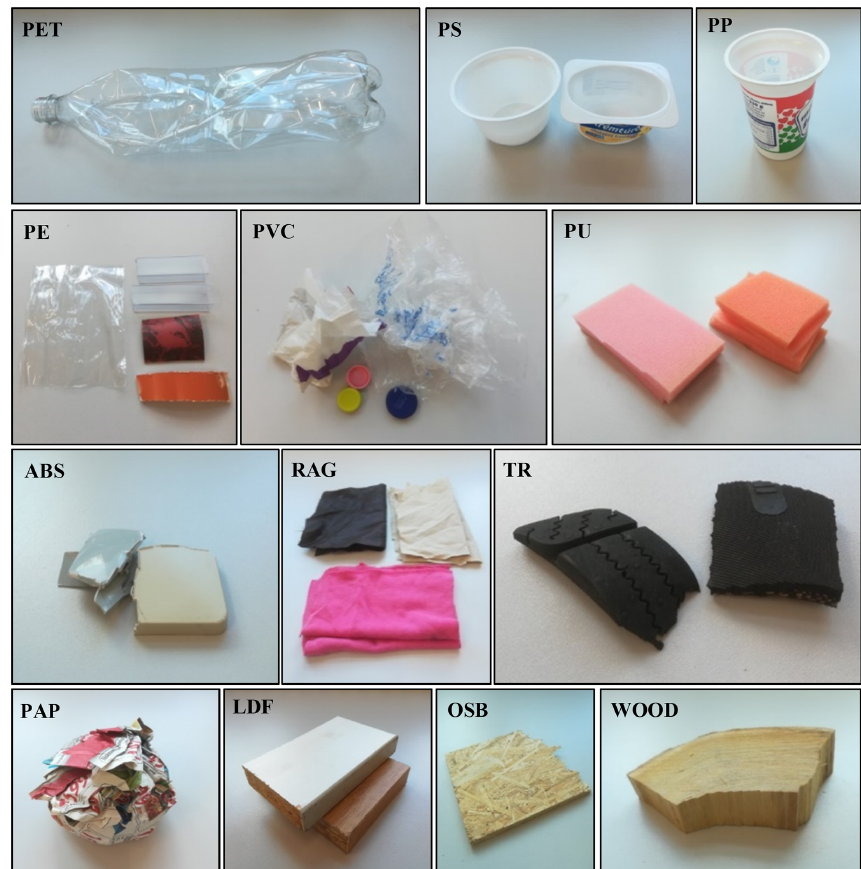
Figure 1. Solid-waste specimens prepared for combustion tests.